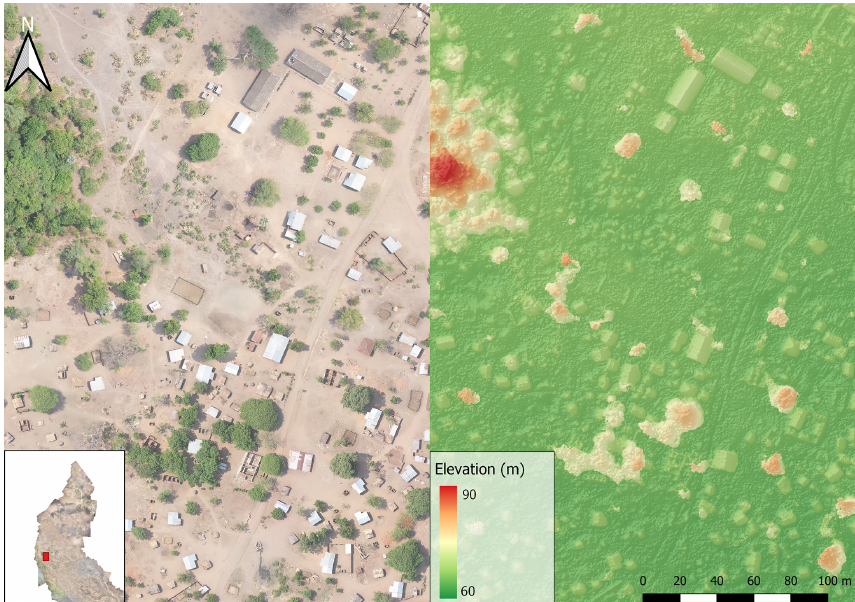
Figure 8. Section of the town of Chagambatuka in the northern part of the UAV campaign area, with orthophoto (left) and DSM with shaded relief (right) produced with images from the UAV flight. Made in QGIS using UAV imagery collected by the Malawi Red Cross Society